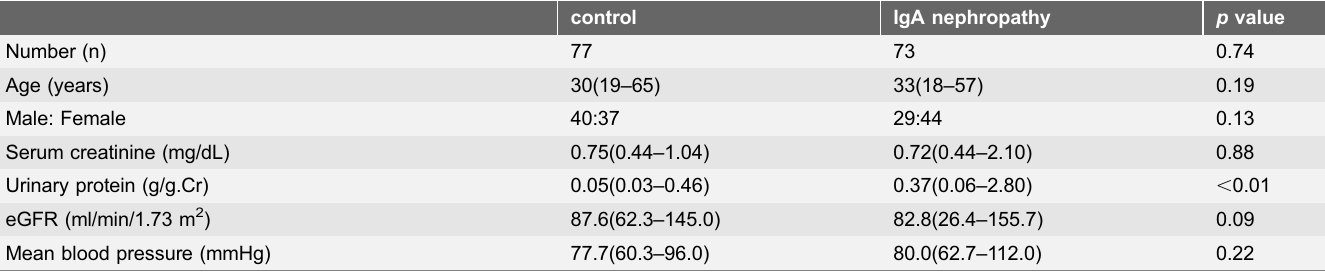
Table 1. Characteristics of the study